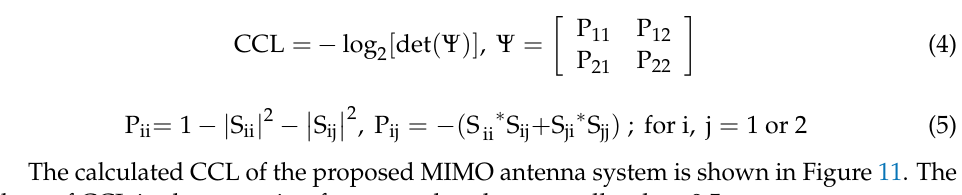
Figure 10. Calculated ME. The channel capacity loss (CCL) is calculated from S-parameters using MATLAB in Equations (4) and (5).